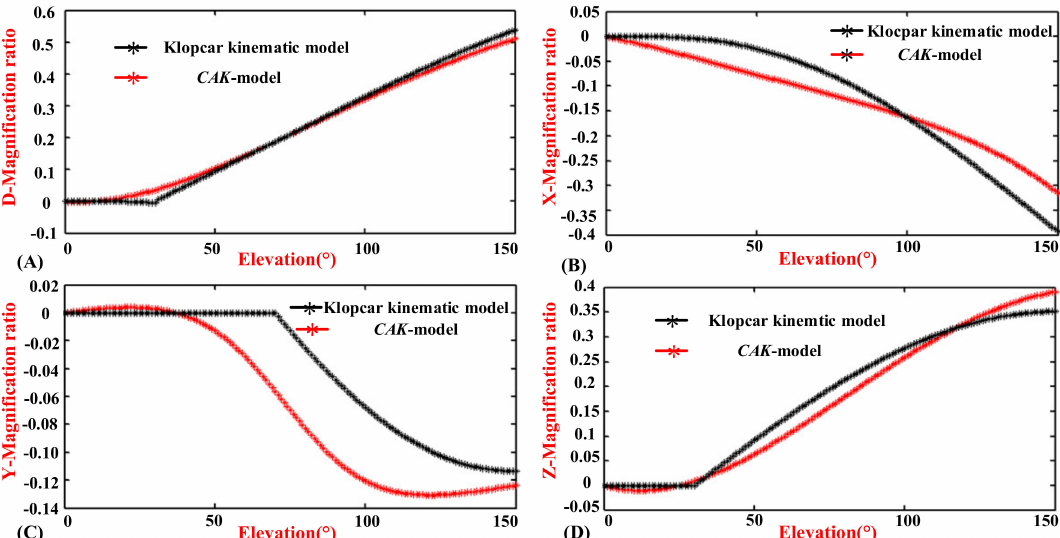
Figure 11. Comparison of the CAK-model and the Klopˇcar Kinematic Model. ( A ) Translational displacement variable quantity d CAK and d ( Φ ). ( B ) Translational displacement variable quantity x CAK and x ( Φ ). ( C ) Translational displacement variable quantity y CAK and y ( Φ ). ( D ) Translational displacement variable quantity z CAK and z ( Φ